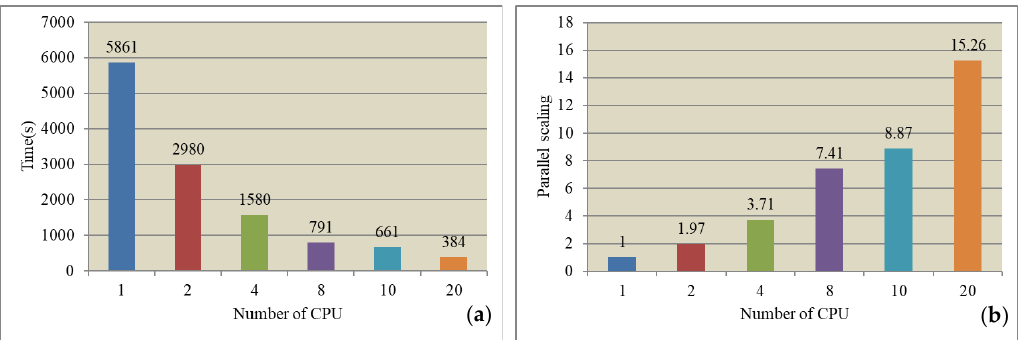
Figure 10. Apparent-resistivity sections of the true model ( a ) and the model ( b ) from 2D inversion.